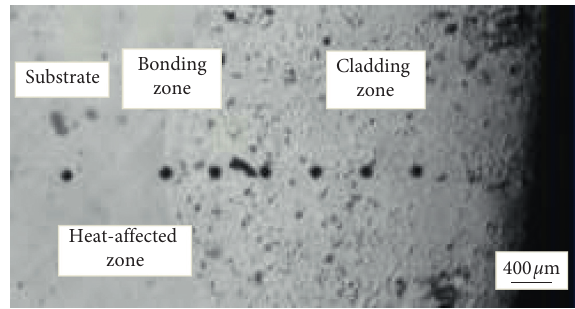
Figure 3: Appearances of hardness marks.